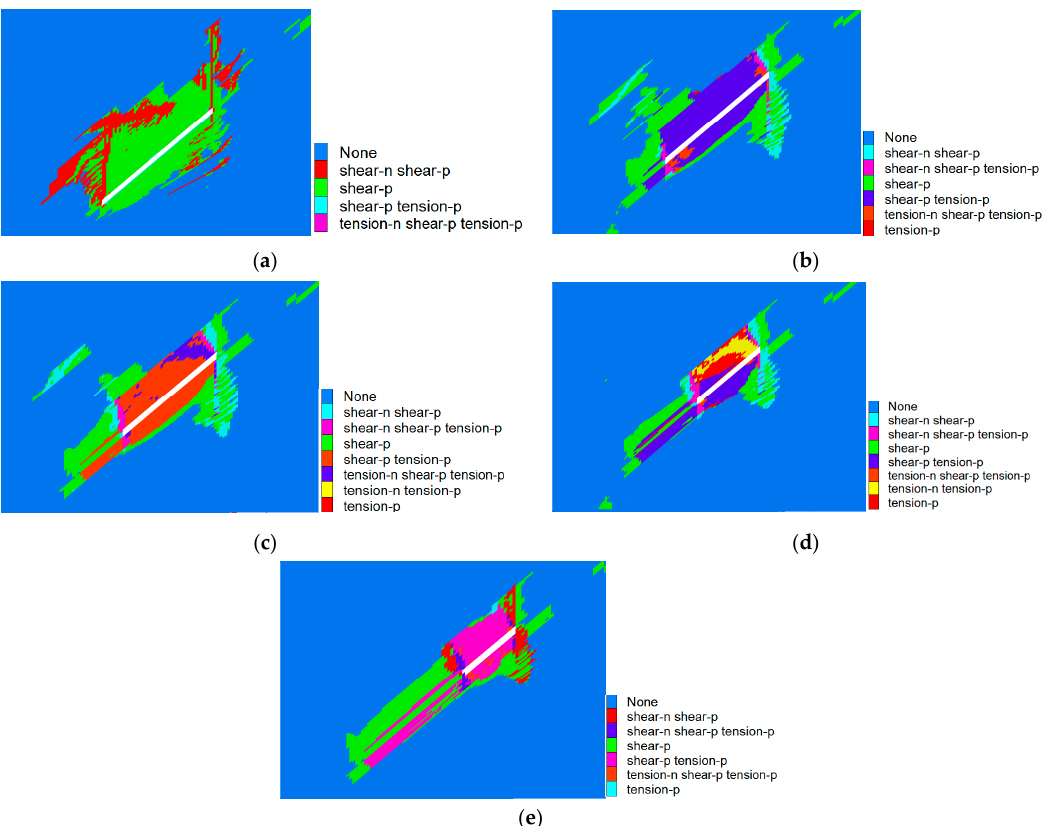
Figure 5. Distribution characteristics and tendency of the overburden plastic zone under different filling quantities. Different colors represent different plastic zone as shown in the right legend. ( a ) No filling; ( b ) Filling 1/5; ( c ) Filling 1/3; ( d ) Filling 1/2; ( e ) Filling 2/3.